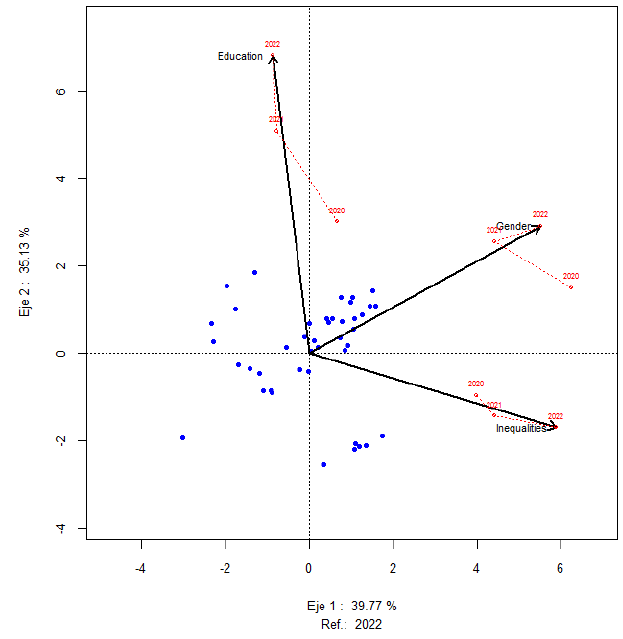
Figure 3. Dynamic biplot factorial representation of THE Impact Rankings (indicators) plane 1–2.